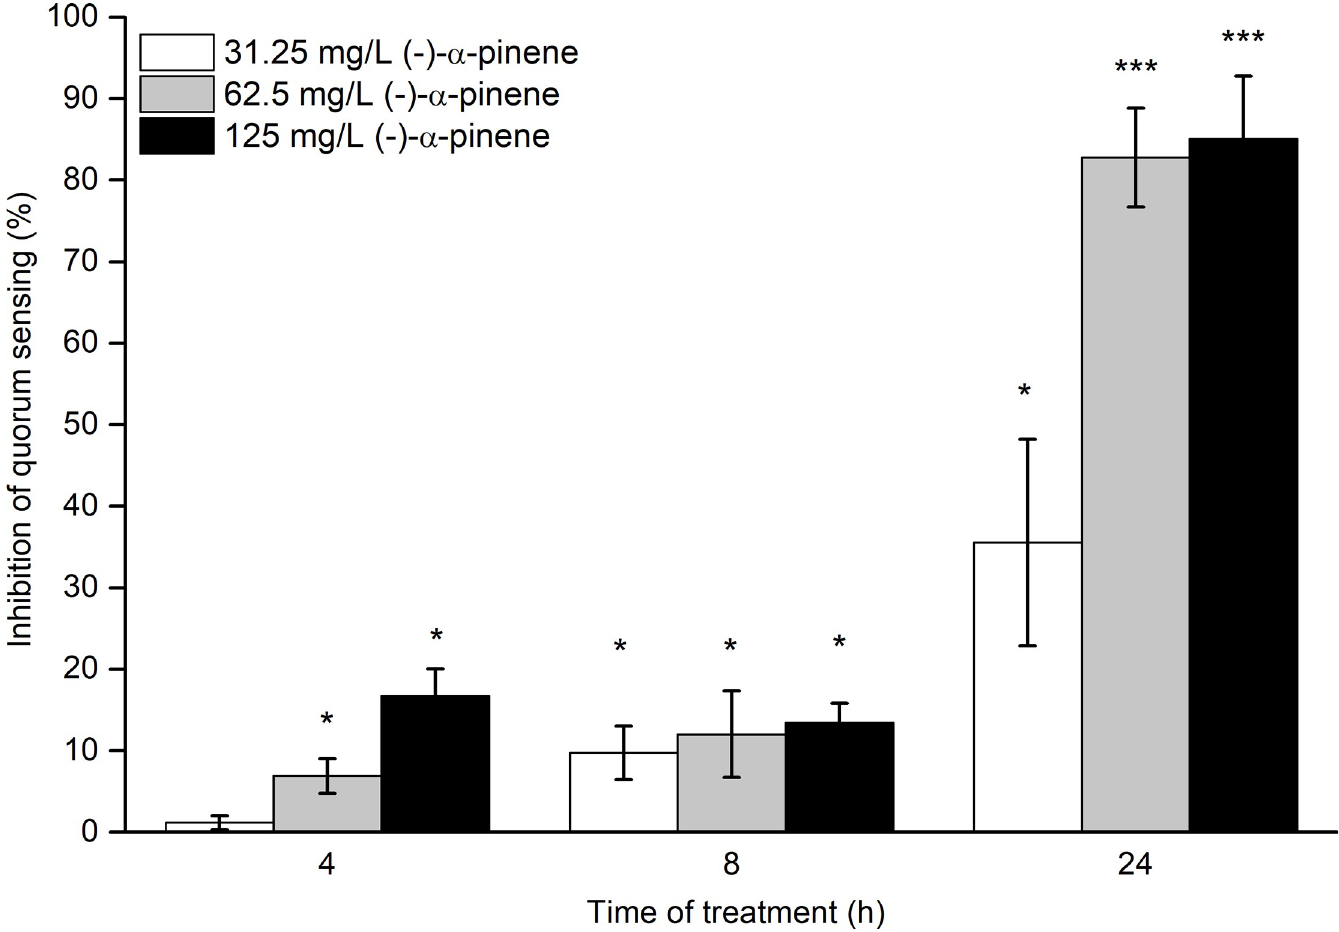
Fig 1. Time-course of (-)- α -pinene inhibition of quorum sensing in C . jejuni NCTC11168. Data are means ± standard deviation of relative reduction of quorum sensing signal (as luminescence of V . harveyi BB170) in the treated C . jejuni cell free supernatants (CFS) versus the untreated C . jejuni CFS, calculated from three replicates. � p < 0.05, ��� p �